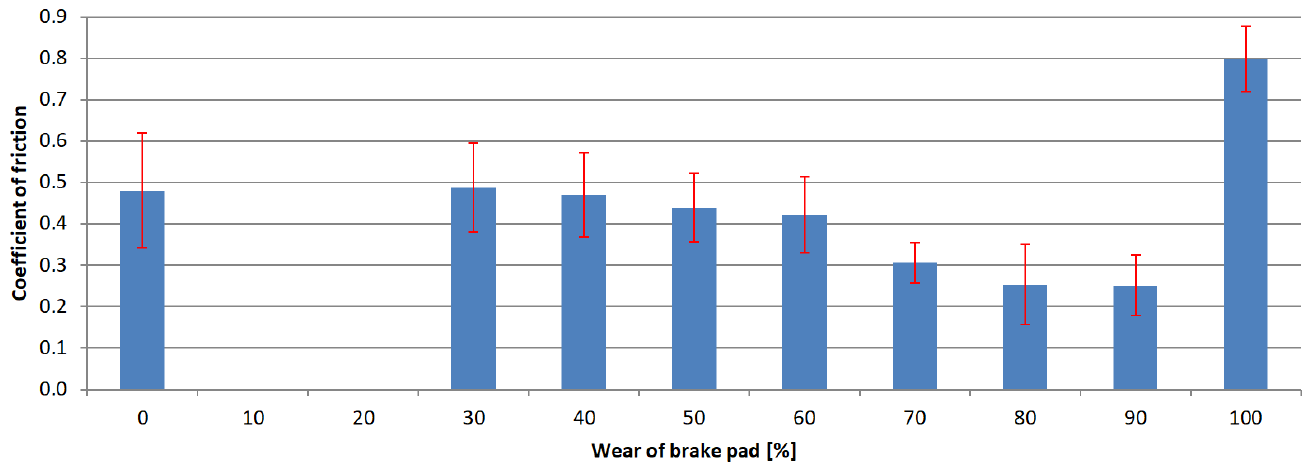
Figure 8. Coefficient of friction values of samples obtained from 3rd brake pad group.